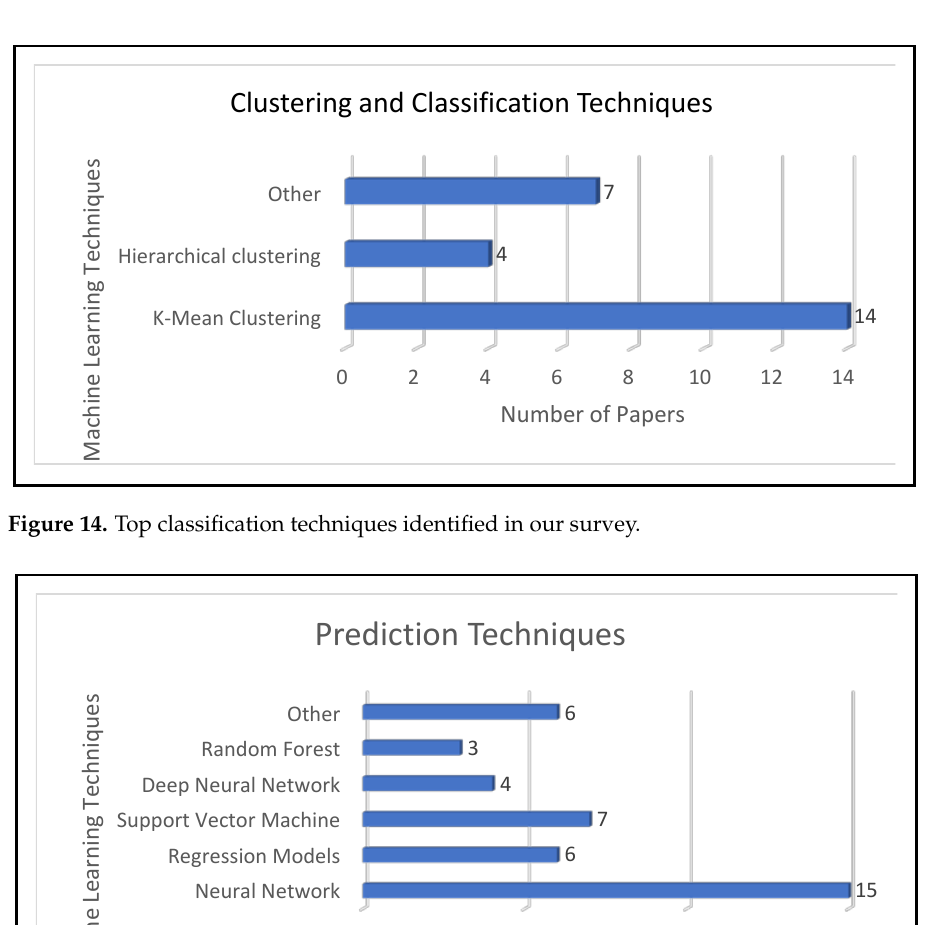
Figure 13. The most relevant factors that influence the energy consumption of buildings, from our survey.